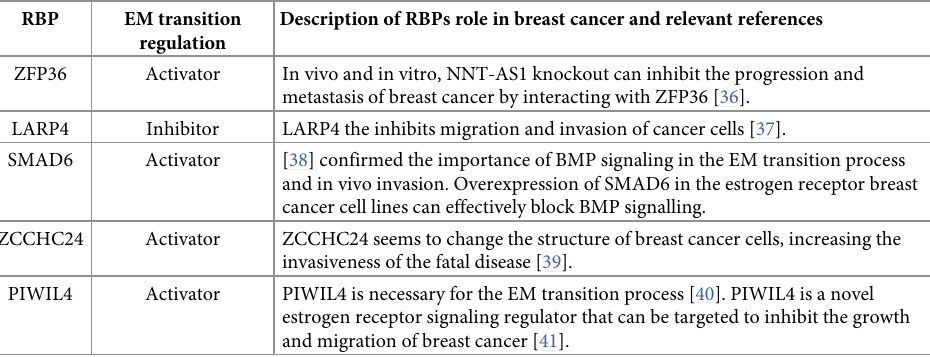
Table 1. RNA-binding proteins (RBPs) reported in previously published literature.